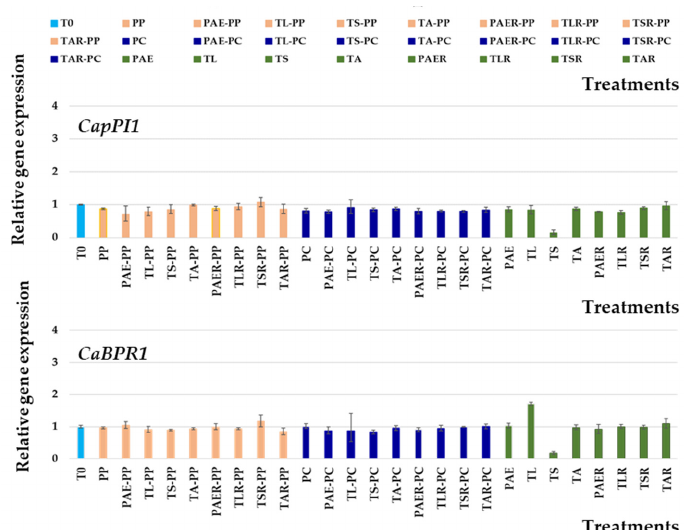
Figure 6. Analysis of the relative expression of defence-related genes CaBGLU , CaRGA1 , CaBPR1 , CaPTI1 , and CaSAR8.2. Each bar represents relative gene expression for all conditions tested. Expressions of genes were normalised with respect to the ACT gene. Values were calculated following three replications, and standard deviations are shown.